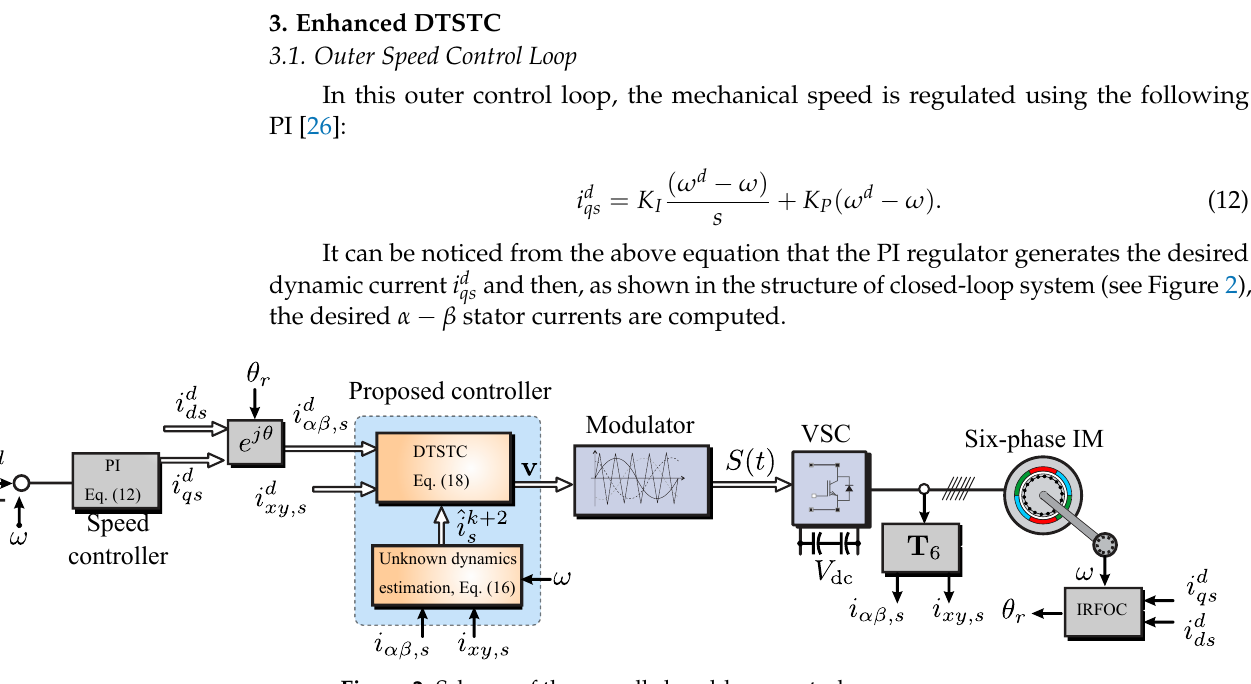
Figure 2. Scheme of the overall closed-loop